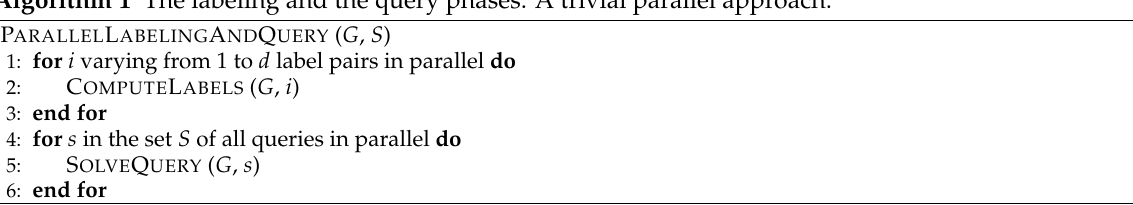
Algorithm 1 The labeling and the query phases: A trivial parallel